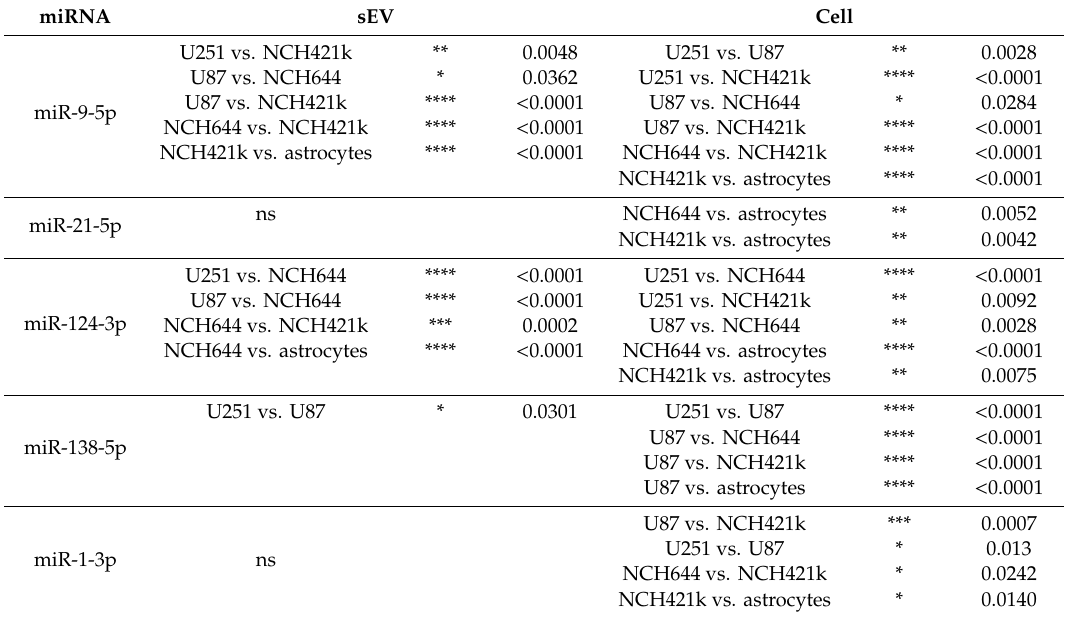
Table 5. Statistical analysis of the qPCR results of the mRNA expression in sEVs. Gene